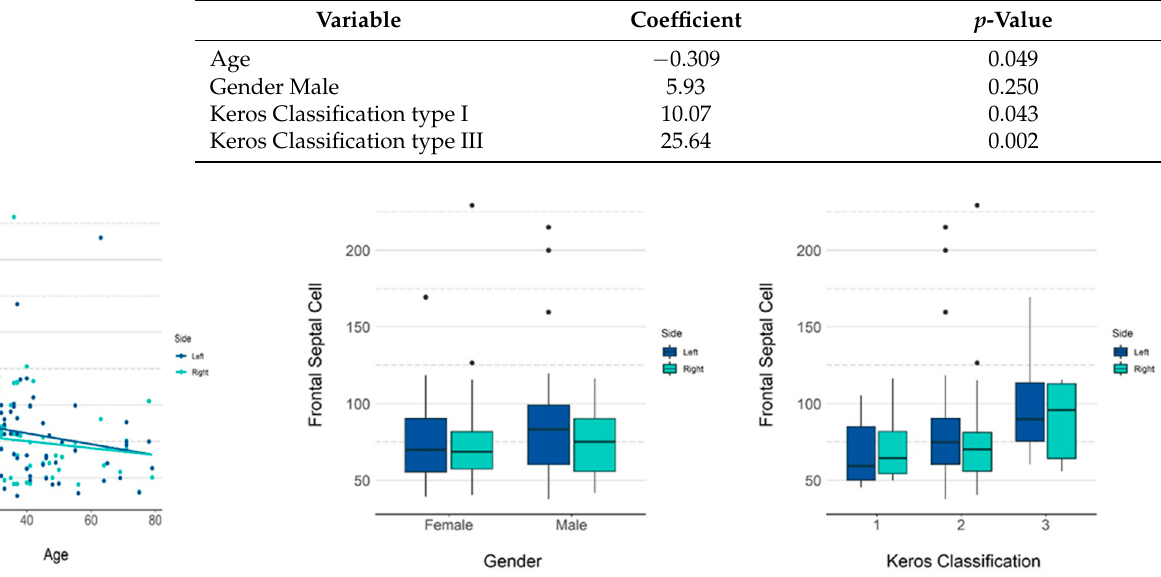
Figure 5. GEE model and scatter plots showing the influence of age and gender and Keros classifi- cation on the volume of the frontal septal cell.